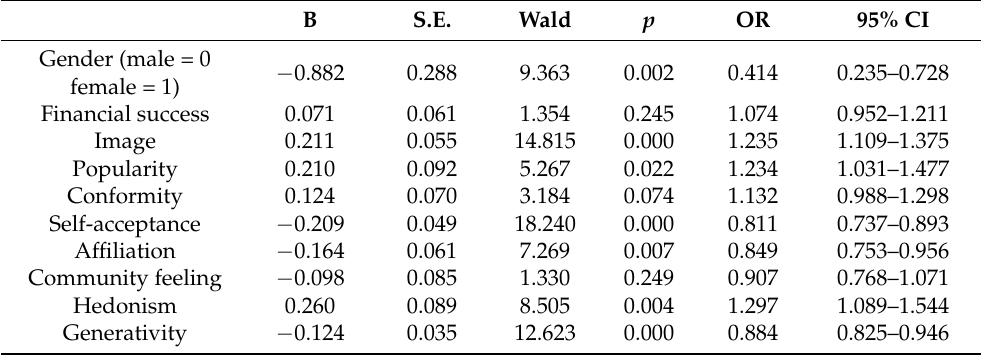
Table 2. Results of the logistic regression analysis with compulsive buying as dependent